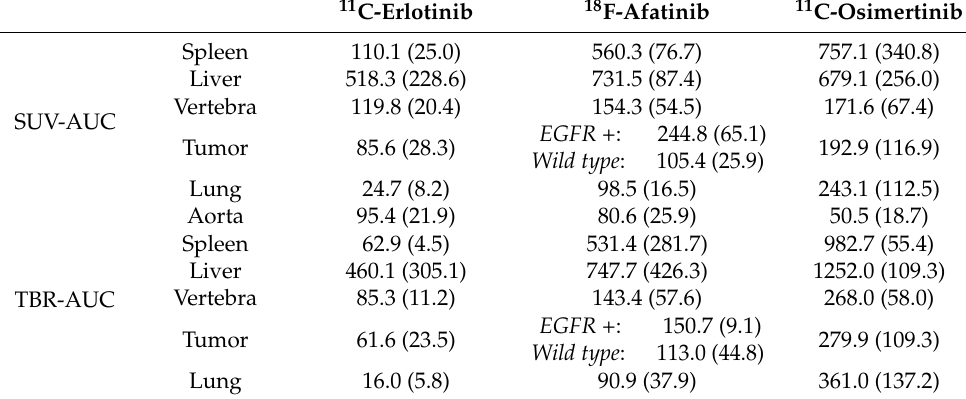
Table 2. AUC values.